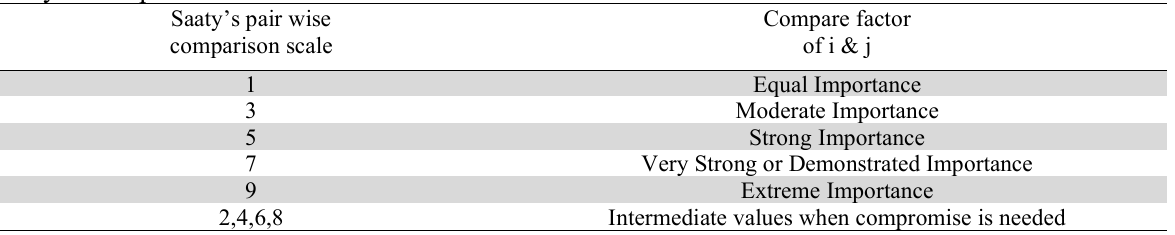
Saaty’s Comparisons Scale